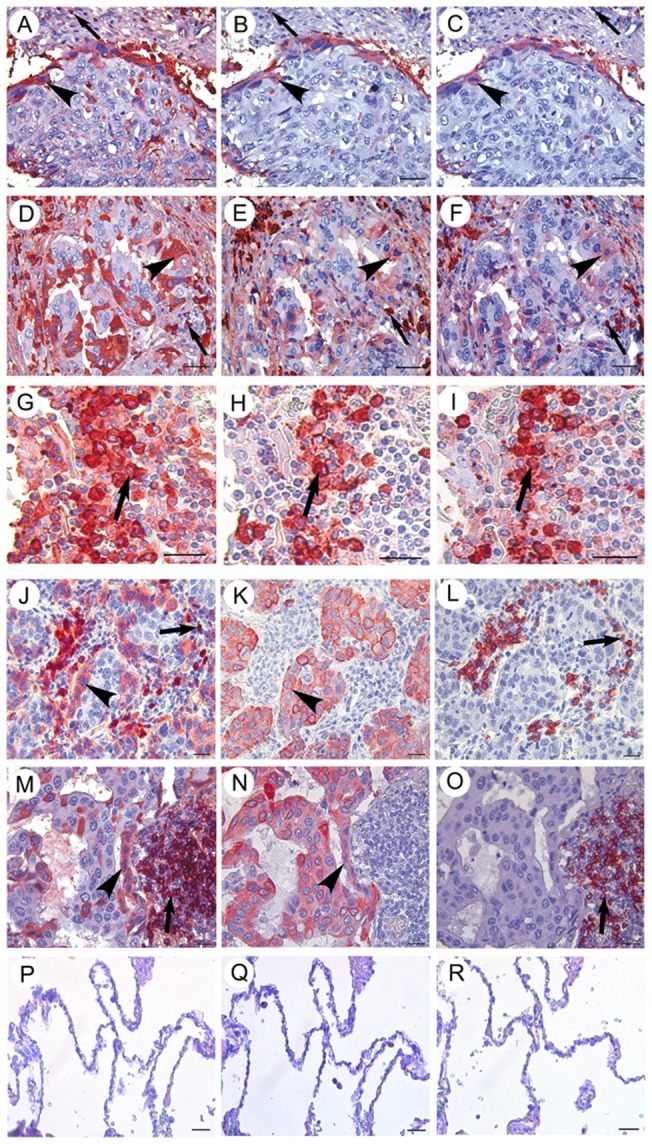
IgG expression in LSCC and LAC with IHC.
A–C, Igγ (A), Igκ (B) and Igλ (C) immunostainings are positive in the cytoplasm and cellular membrane of LSCC on serial sections. Note: The IgG positive cancer cells are distributed at the periphery of the tumor mass. D–F, positive signals for Igγ (D), Igκ (E) and Igλ (F) are shown in the cytoplasm and cellular membrane of a LAC. G–I, Igγ (G), Igκ (H) and Igλ (I) expressions are detected in lymphocytes of tonsil tissues as a positive control. J–L, Igγ (J), pan CK (K) and CD20 (L) are expressed in LSCC on serial sections. M–O, Igγ (M), pan CK (N) and CD20 (O) are expressed in serial sections of LAC. Igγ(P), Igκ (Q) and Igλ (R) are not expressed in normal epithelial cells adjacent to tumor mass on serial sections. Black arrowheads point to the same cancer cell on serial sections. Black arrows point to positive lymphocytes. With AEC colorization, the positive immunostainings with AEC are red in color. Note: IgG is positive in both cancer cells and infiltrating lymphocytes with the latter stronger than the former. Scale bar: 20 µm.